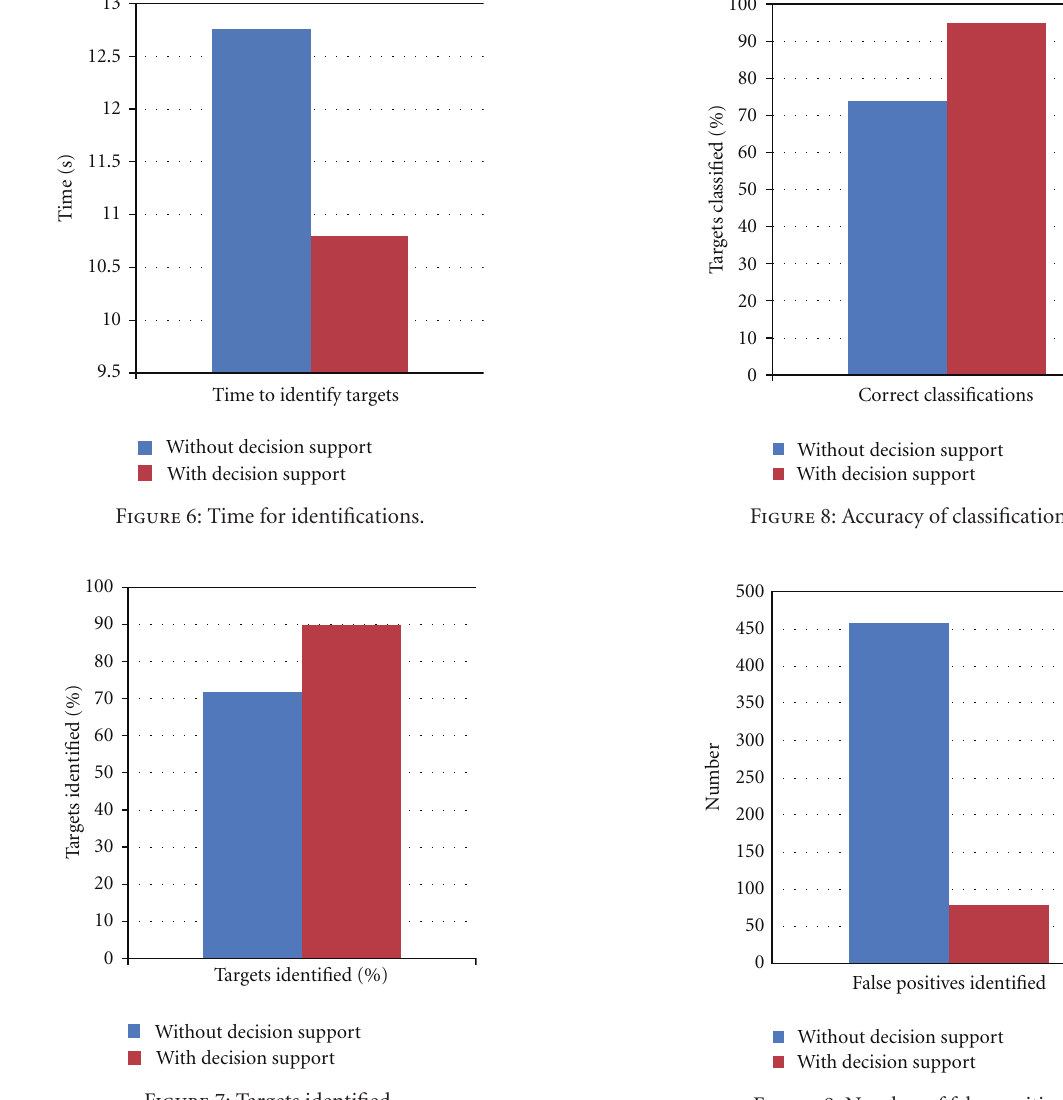
Figure 9: Number of false